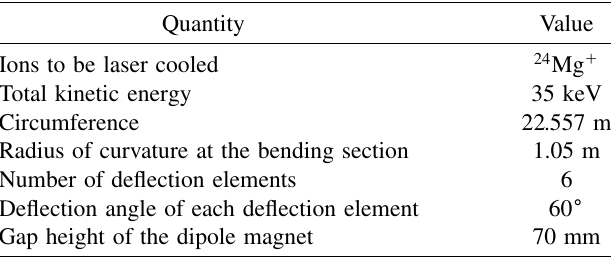
TABLE I. Main parameters of S-LSR (storage of 24 Mg (cid:2) )